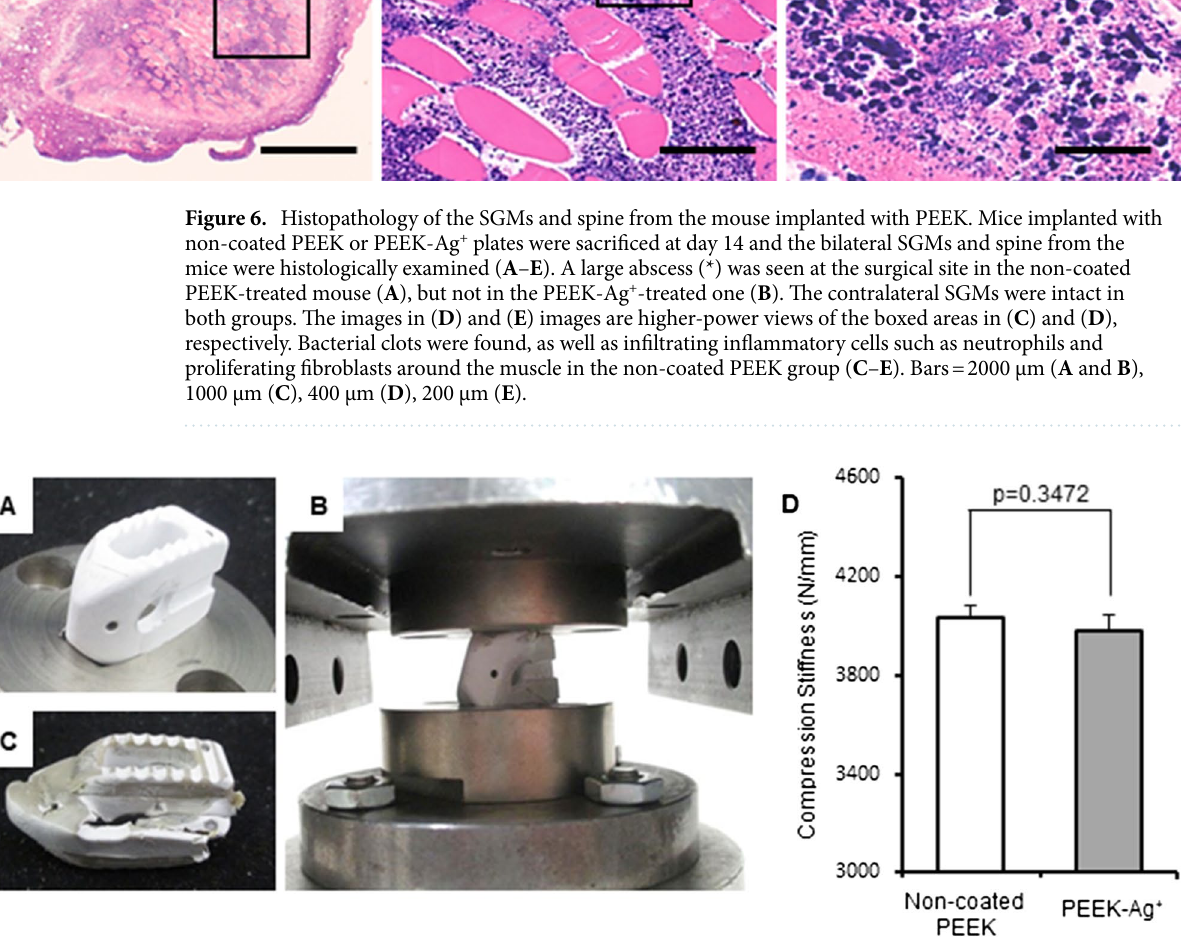
Figure 7. Validation of biomechanical stability. Intervertebral spinal cages were prepared by Ortho Development (VUSION). A biomechanical compression test was performed for non-coated PEEK and PEEK-Ag + cages ( A – C ). The average compression stiffness of the non-coated PEEK and PEEK-Ag + cages was 4034 ± 49 N/mm and 3980 ± 65 N/mm, respectively ( D ). There was no significant difference between the two groups ( p = 0.347). Results shown are means ± standard errors of the mean